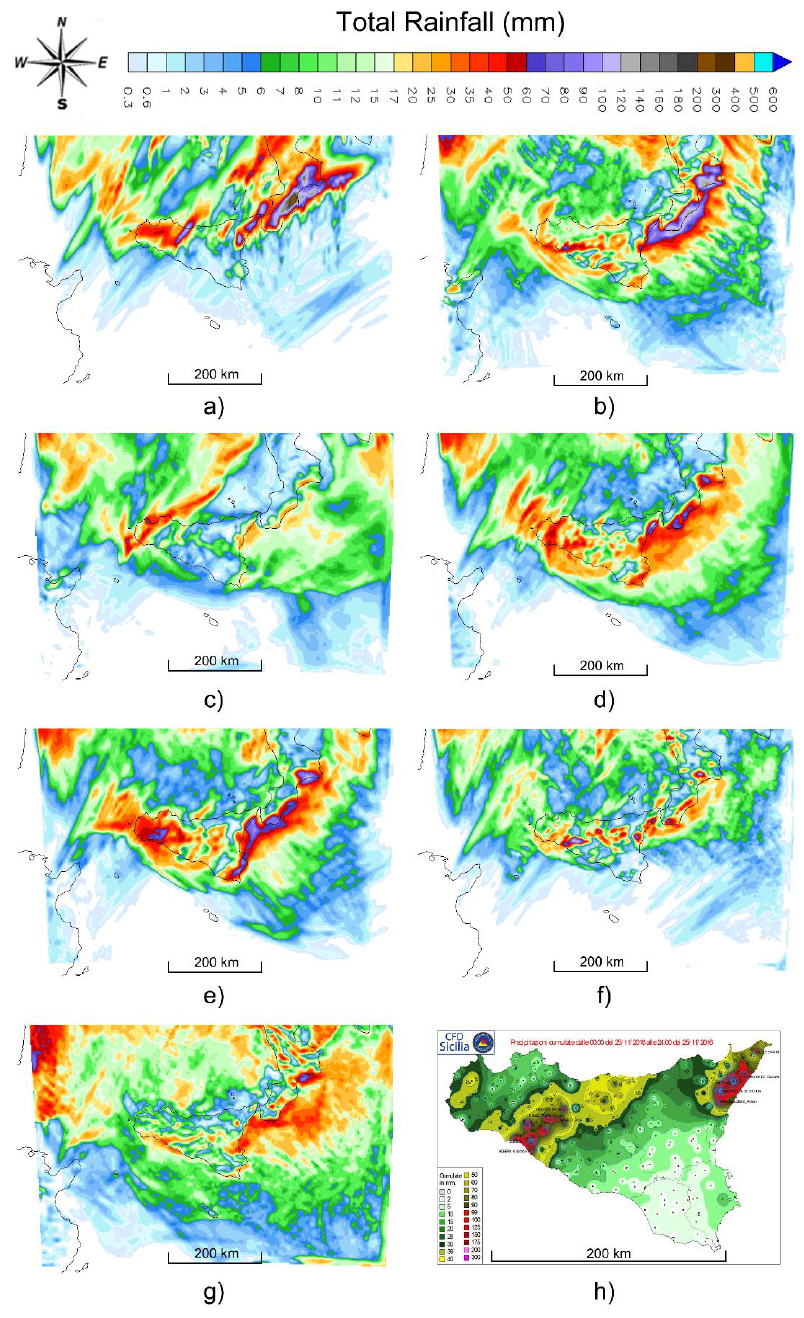
Figure 7. Total rainfall maps (accumulate + convective) obtained through the WRF model using different physical parametrizations of convective schemes and map of data observed by the DRPC weather stations network. ( a ) The CUO convective parameterization; ( b ) the CU1 convective parameterization; ( c ) the CU2 convective parameterization; ( d ) the CU3 convective parameterization; ( e ) the CU5 convective parameterization; ( f ) the CU6 convective parameterization; ( g ) the CU14 convective parameterization; ( h ) the map of a pluviometric data observation provided by the Regional Department of Civil Protection (DRPC) of